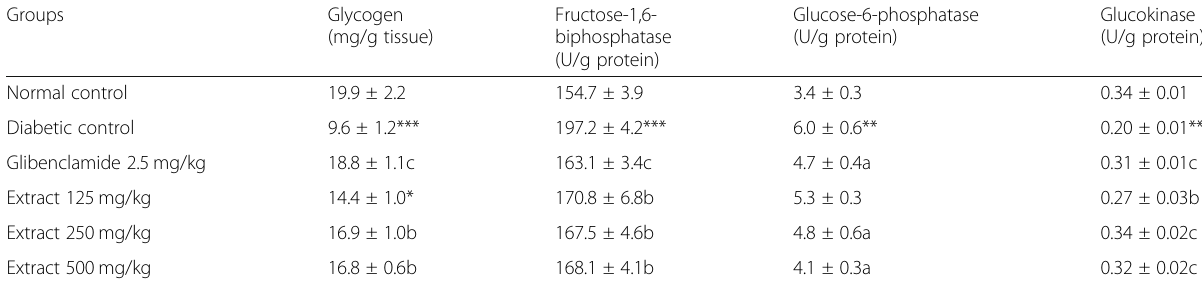
Table 3 Effect of Vitellaria paradoxa on glycogen content and some hepatic enzymes activities in alloxan-induced diabetic rats